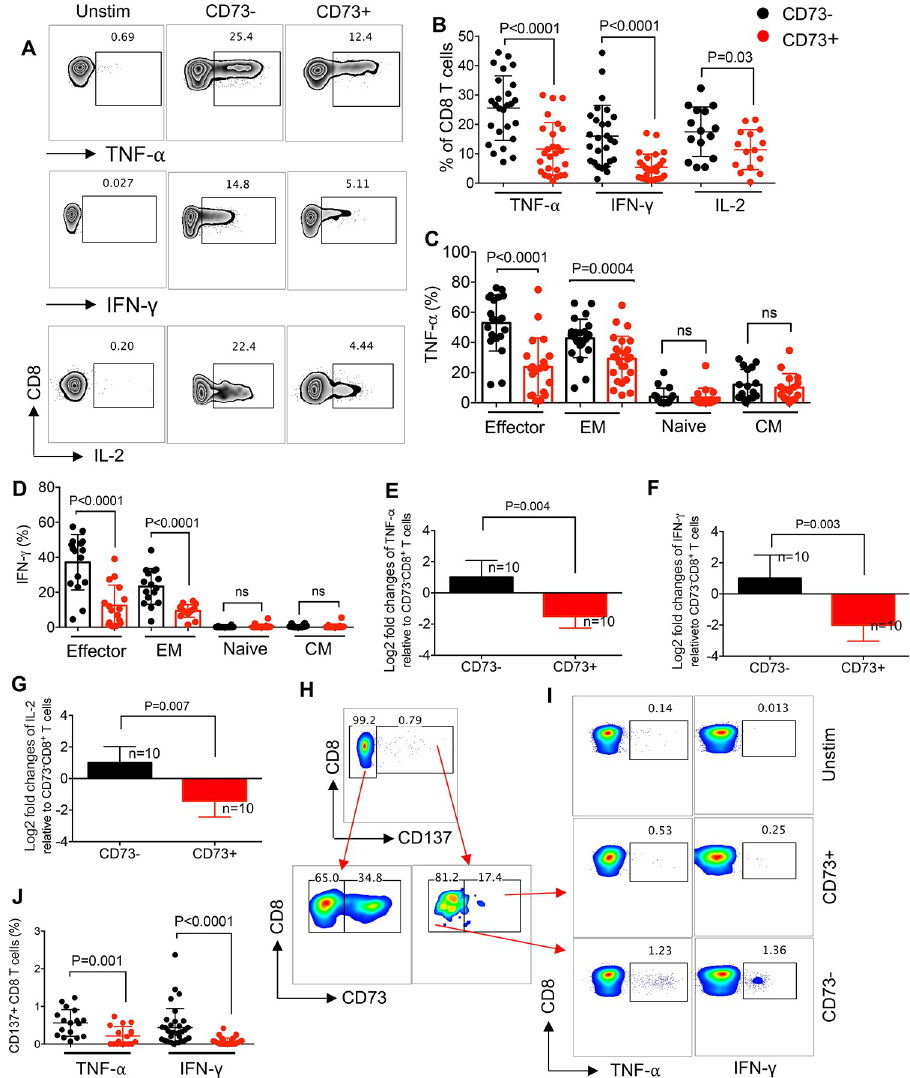
Fig 3. Impaired effector functions of CD73 + CD8 + T cells compared to CD73 - CD8 + T cells in PBMCs of HIV- infected individuals. ( A ) Representative flow cytometry plots, and ( B ) Cumulative data of TNF- α , IFN- γ , and IL-2 expression in CD73 + versus CD73 - CD8 T cells upon stimulation of PBMCs from HIV-infected individuals with anti- CD3/CD28. ( C ) Cumulative data of TNF- α , and ( D ) IFN- γ expression in CD73 + versus CD73 - in different subsets of CD8 + T cells of HIV-infected individuals. ( E-G ) Fold regulation of TNF- α , IFN- γ , and IL-2 genes in CD73 + CD8 + T cells relative to CD73 - CD8 + T cells of HIV-infected individuals quantified by qPCR. ( H ) Gating strategy and the representative plots showing CD73 + cells among CD137 + CD8 + T cells compared to CD137 - CD8 + T cells, and ( I ) Cumulative data of TNF- α and IFN- γ expression in CD73 + versus CD73 - CD137 + CD8 + T cells upon stimulation of PBMCs from HIV-infected individuals with the Gag peptide pool. Each point represents one HIV-infected individual. Data are obtained from multiple independent experiments. Each dot represents data from an individual human subject. Statistical analysis determined by the Mann-Whitney U-test (B, C, D-G and J) with significance indicated. ns, no significant. n: reflects the number of